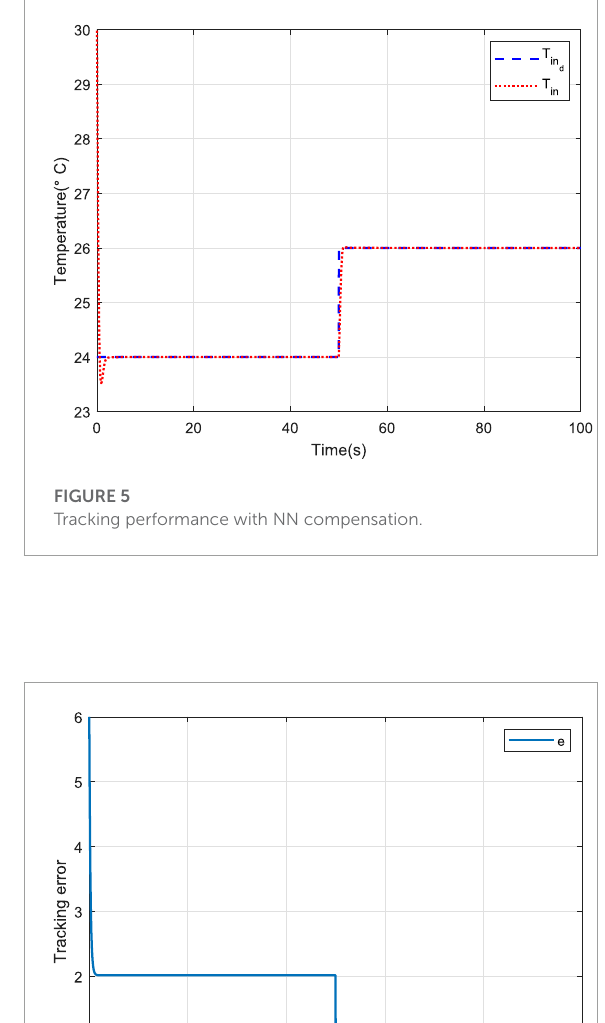
TABLE 1 Parameters of the system.